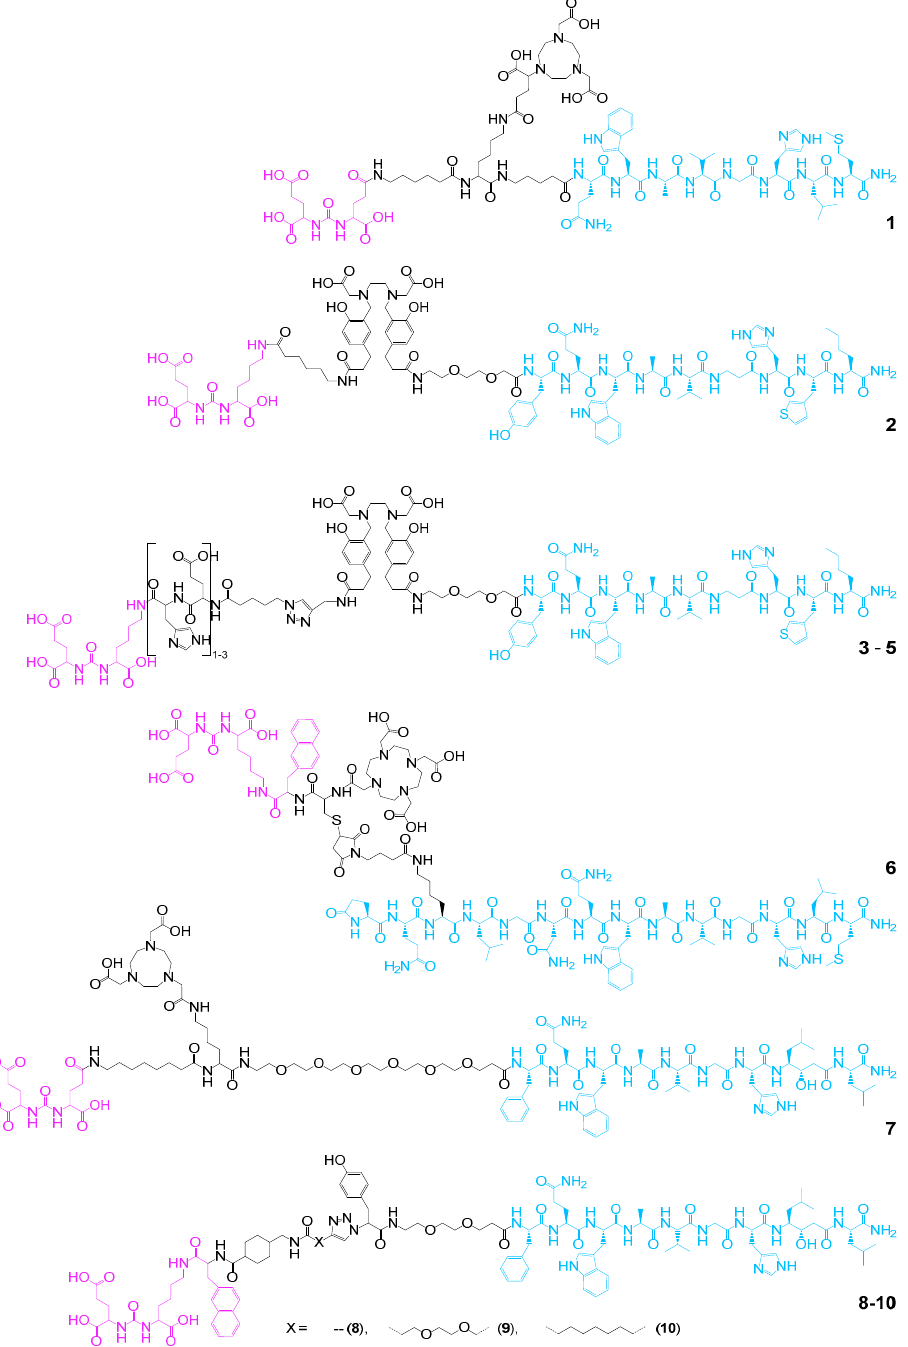
Figure 6. Structures of GRPR- and PSMA-bispecific agents developed for prostate carcinoma (PCa) imaging or therapy. PSMA-specific binders are depicted in magenta, GRPR-specific ones in blue. It could be shown for both agents 1 and 2 that they were taken up by GRPR- and PSMA- expressing PC3 and LNCaP tumor cells by specific interaction with the respective target receptors showing good affinities ( 1 : IC 50(GRPR) : 11.1 ± 0.5 nM, IC 50(PSMA) : 1.2 ± 1.4 nM; 2 : IC 50(GRPR) : 9.0 ± 1.8 nM, IC 50(PSMA) : 25.0 ± 5.4 nM) in the same range or slightly decreased compared to the corresponding peptide monomers. The uptake could furthermore be blocked by the respective monomeric agents.